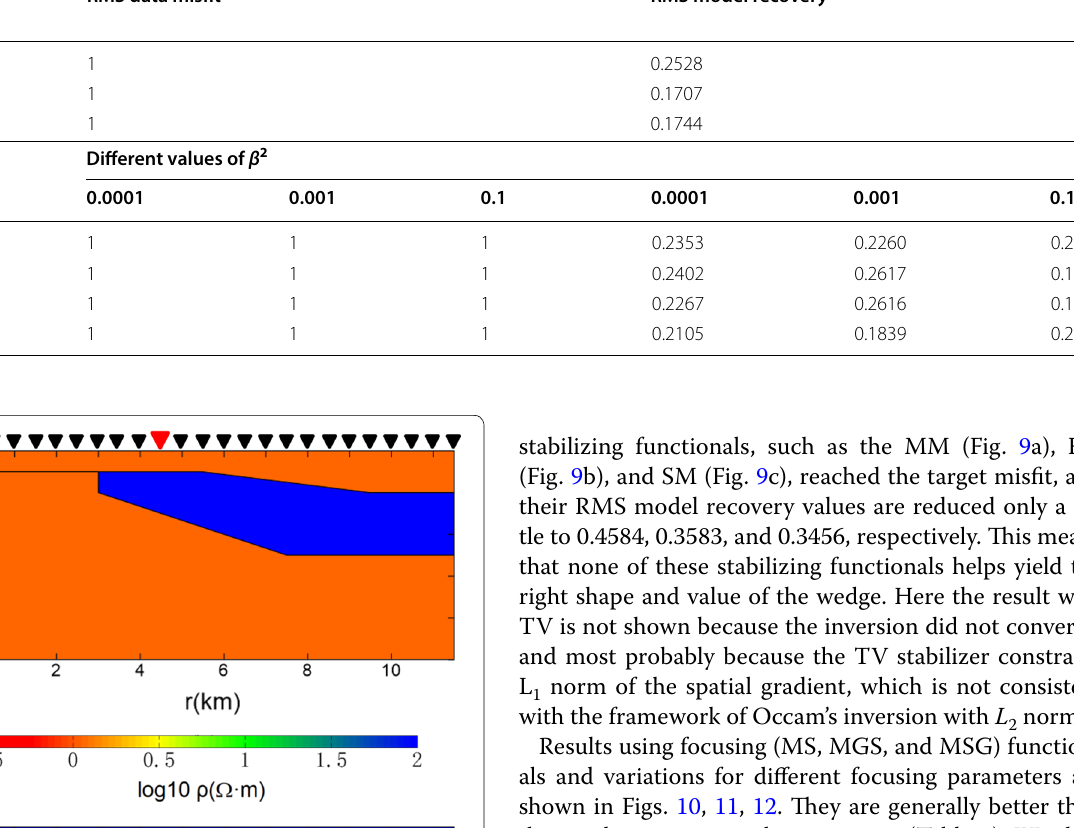
Table 7 RMS data misfit and RMS model recovery of different stabilizing functionals for 1D smooth boundary model Stabilizing functional